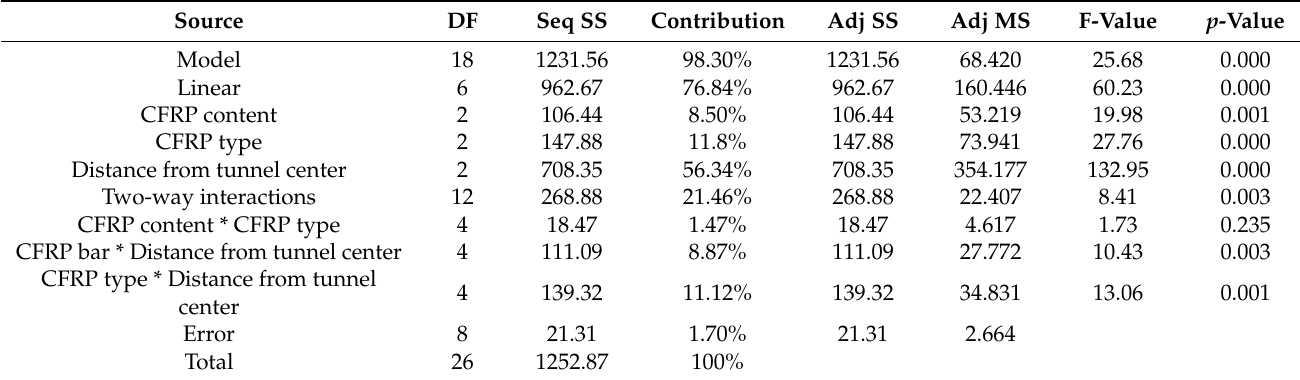
Table 8. Analysis of variance for speed of 100 km/h.